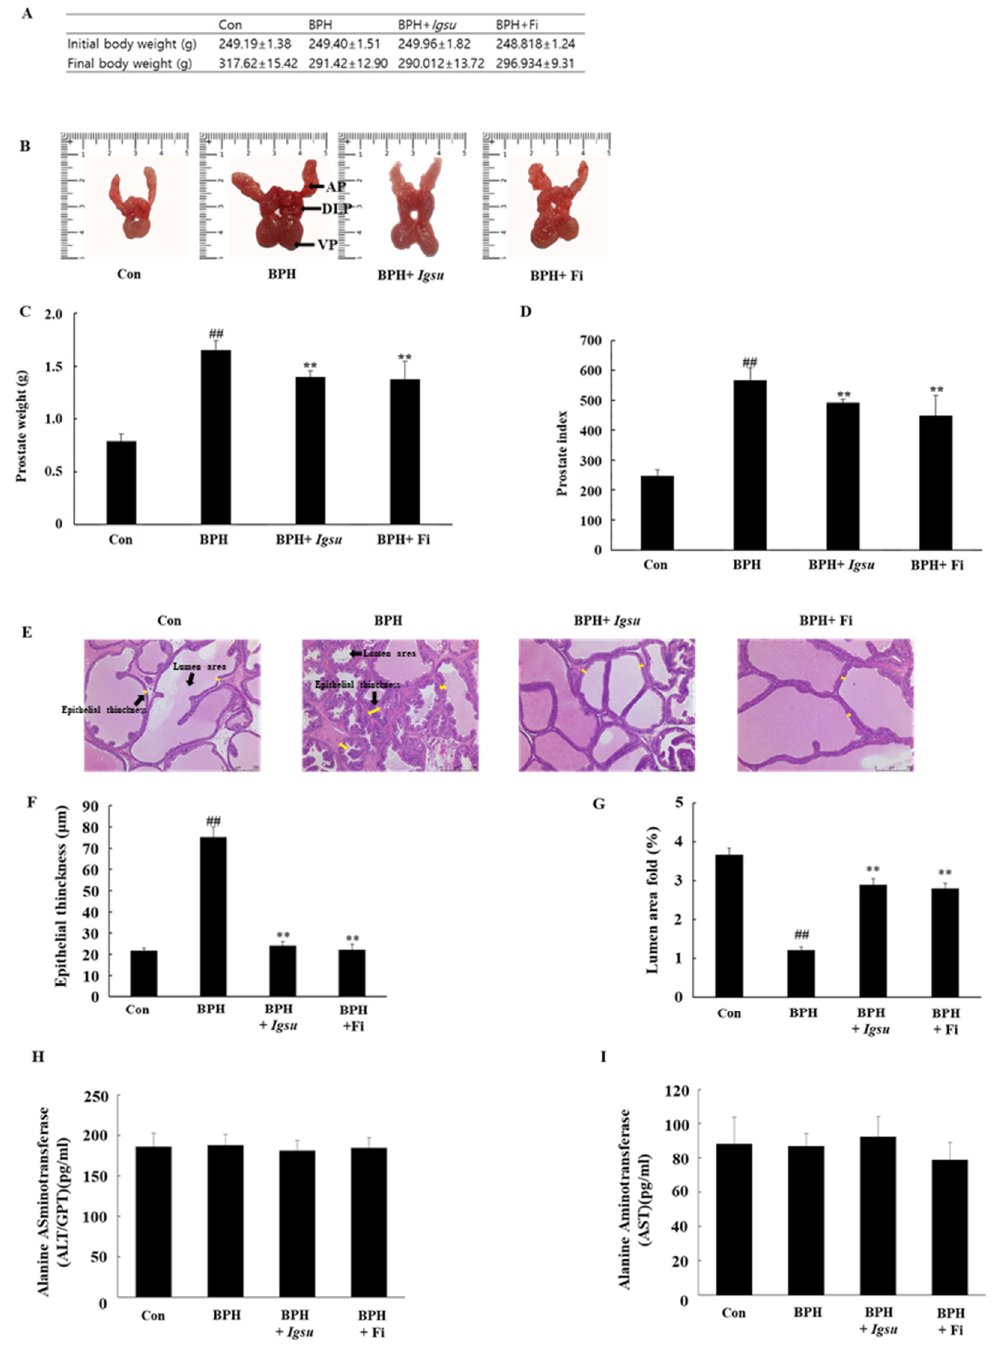
Figure 4. Evaluation of prostate weight and toxicity according to administration of Igsu in benign prostatic hyperplasia (BPH). ( A ) Body weight of the rats in the different groups. ( B ) Dorsolateral prostate lobe (DLP), anterior prostate lobe (AP), and ventral prostate lobe (VP) dissected from the different groups. ( C ) The total prostate weight of the rats. ( D ) Prostate indexes in different groups. ( E ) Hematoxylin and eosin (H&E) staining of prostate tissue sections. ( F ) Epithelial thickness of the prostate tissues. ( G ) Lumen area fold in the prostate tissues. ( H ) Concentration of alanine transaminase (ALT) in the serum. ( I ) Concentration of aspartate transaminase (AST) in the serum. Con, normal control group; BPH, testosterone propionate (TP) (3 mg/kg/day)/corn oil injection; BPH + Igsu , Igsu -treated BPH group; BPH + Fi, finasteride (Fi)-treated BPH group. Data are presented as the mean ± standard error of the mean (SEM) ( n = 8). Significant differences at ## p < 0.01 compared with the Con group. Significant differences at * p < 0.05, ** p < 0.01 compared with the BPH group.